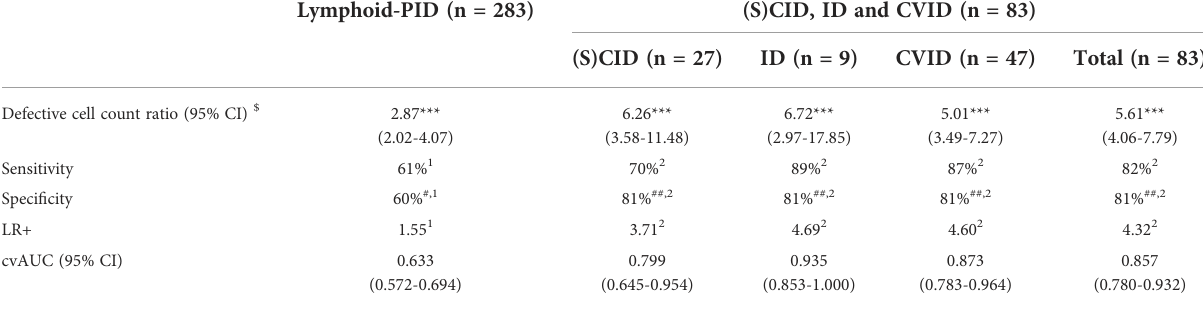
TABLE 2 Sensitivity and speci fi city to identify lymphoid-PID diagnostic groups from non-PID disease controls in relation to the number of defective lymphoid populations detected with